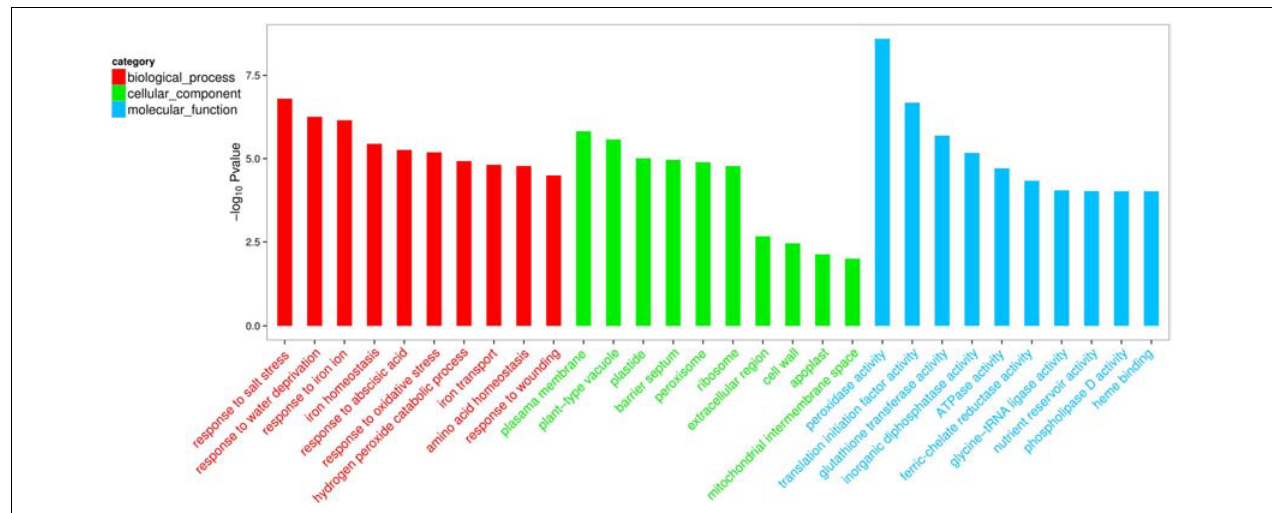
FIGURE 7 | List of top 10 significant GO terms for up-regulated differentially expressed genes (DEGs) of SA03-inoculated plants based on GO classifications. GO terms were categorized into three groups: biological process, cellular component and molecular function. The P -value indicates the significance of the comparison between the non-inoculated and inoculated